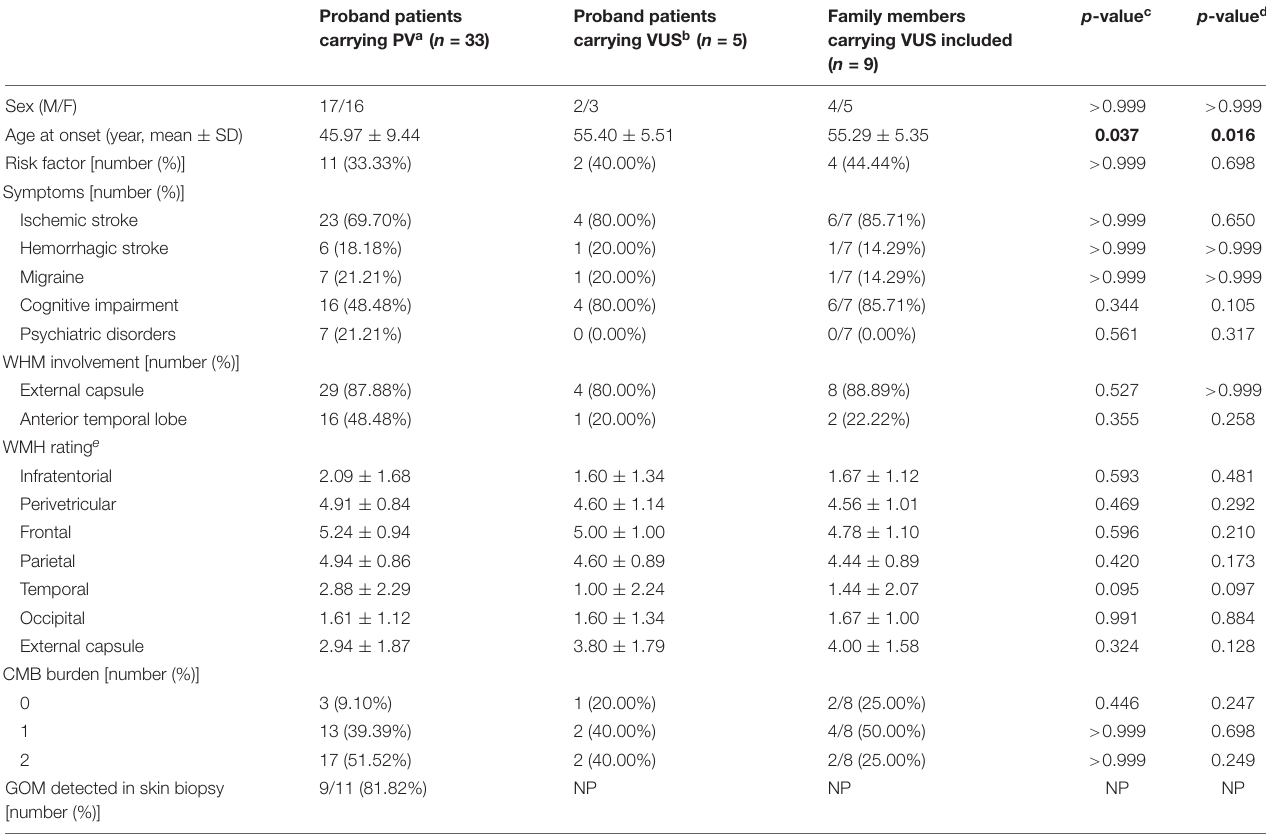
TABLE 6 | Comparison of clinical features between patients carrying pathogenic variants and